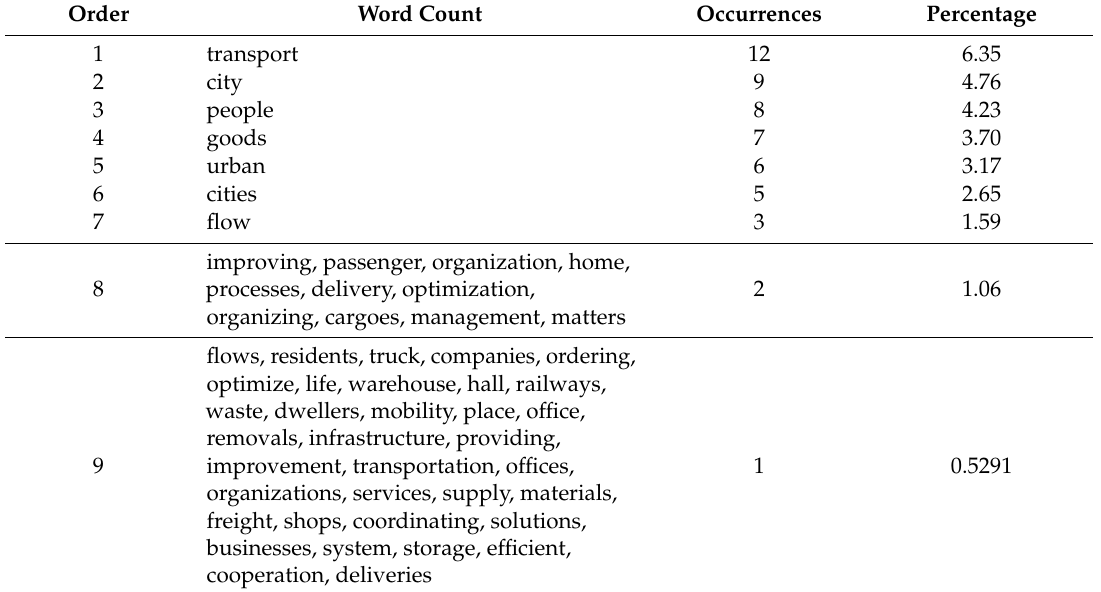
Table A4. Text mining results (Q1).